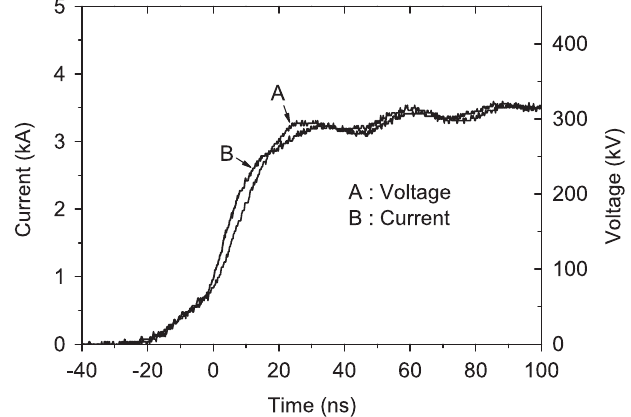
FIG. 13. Amplitudes of the voltage (A) and the current (B) of the water load when high amplitude of the output voltage from the Marx generator is supplied to the water load.